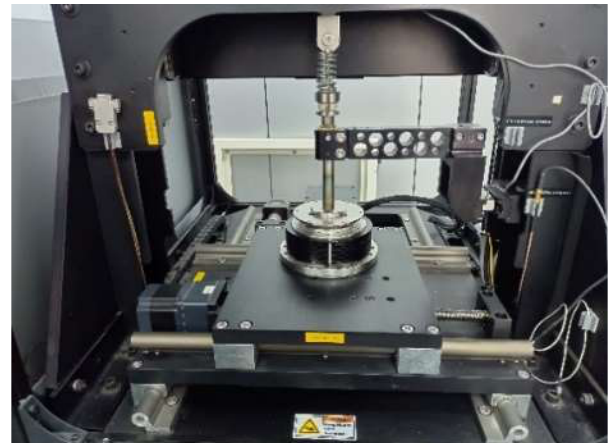
Figure 4. MFT-5000 Friction and wear test bench. Table 3. Parameters of texture samples.